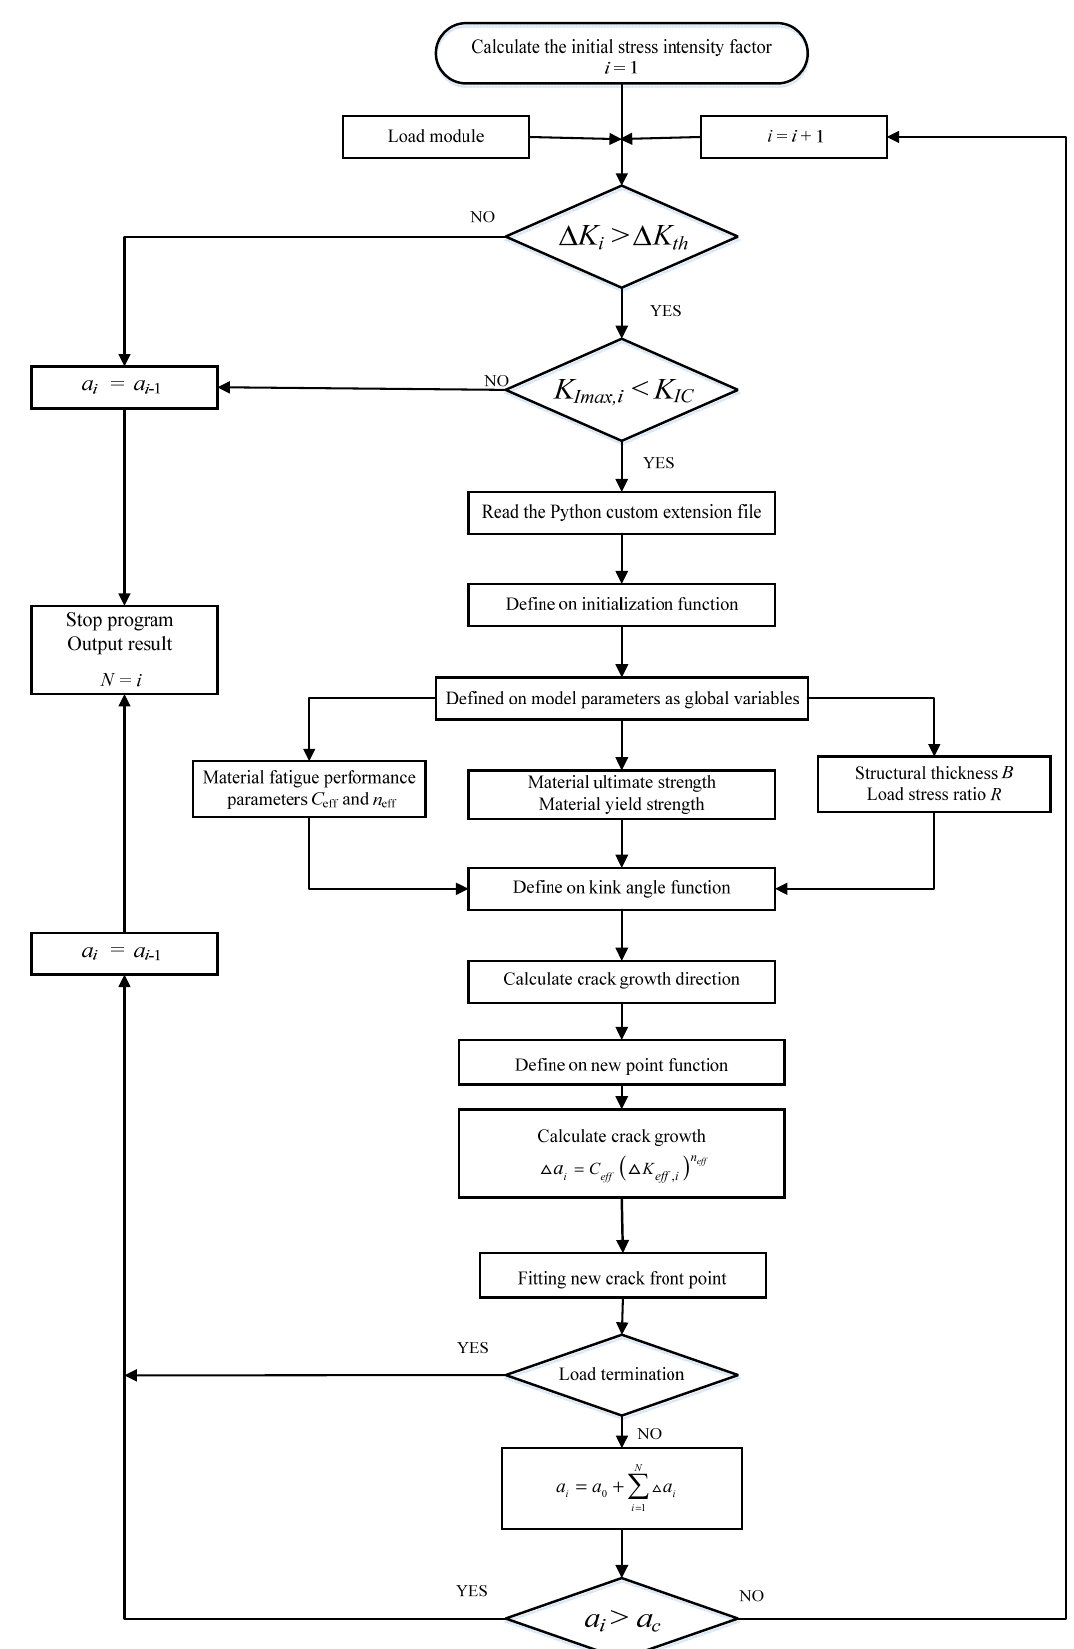
Figure 6. Simulation flow of surface crack growth of the spherical shell.